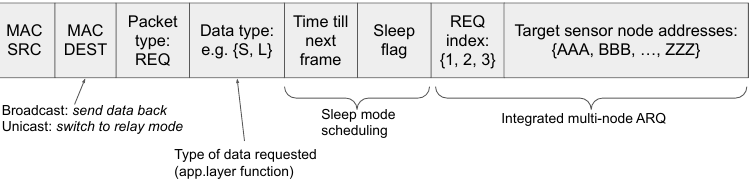
Figure 8. REQ packet structure: integrating multiple network protocol functions from different layers in a single control packet.